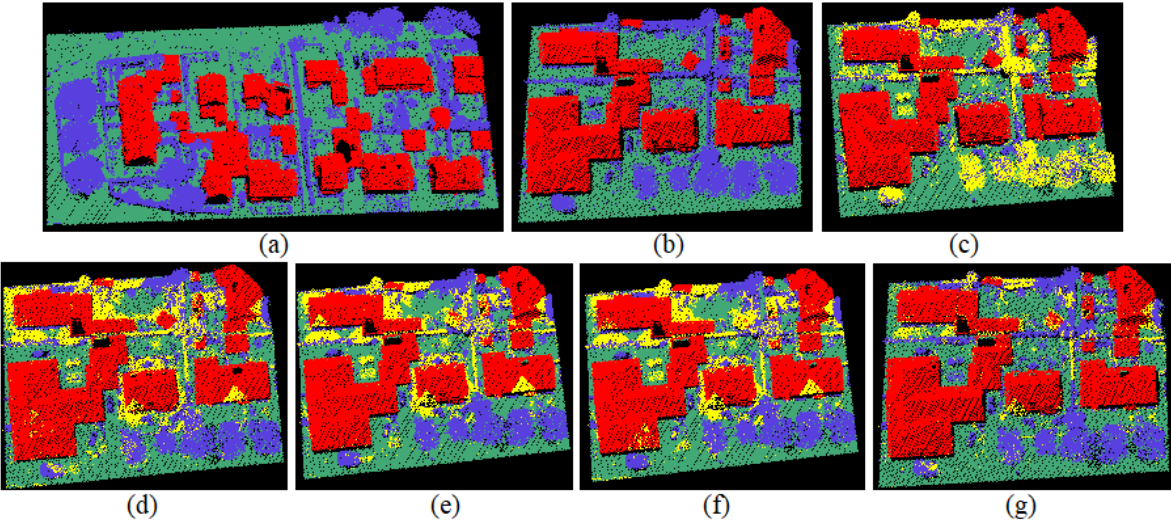
Figure 4 . (a) AHN training and validation data, (b) AHN test data, classification results based on: (c) train/test split, (d) k -CV, (e) R k - CV, (f) MC-CV, and (g) bootstrap.